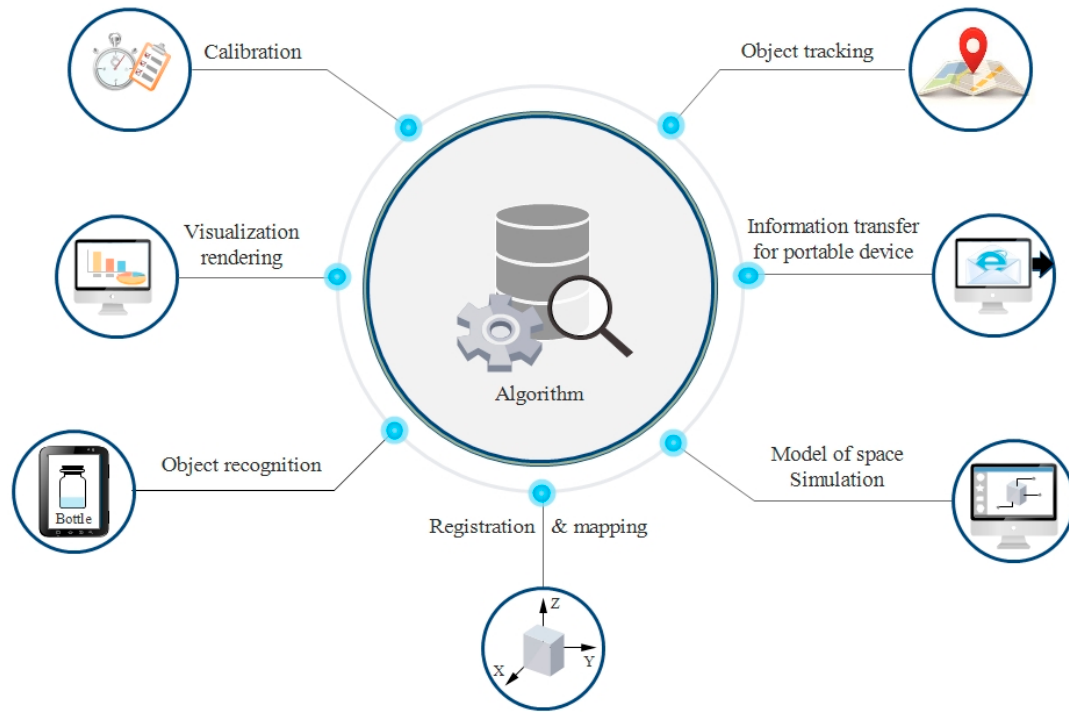
Figure 5. Mixed reality algorithm.